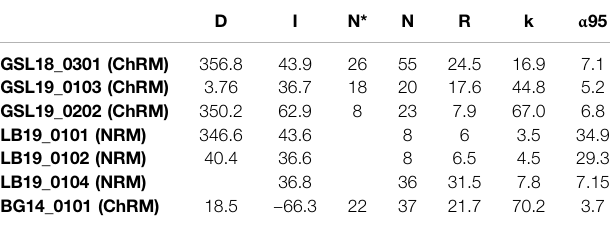
TABLE 3 | Sample-average Fisher